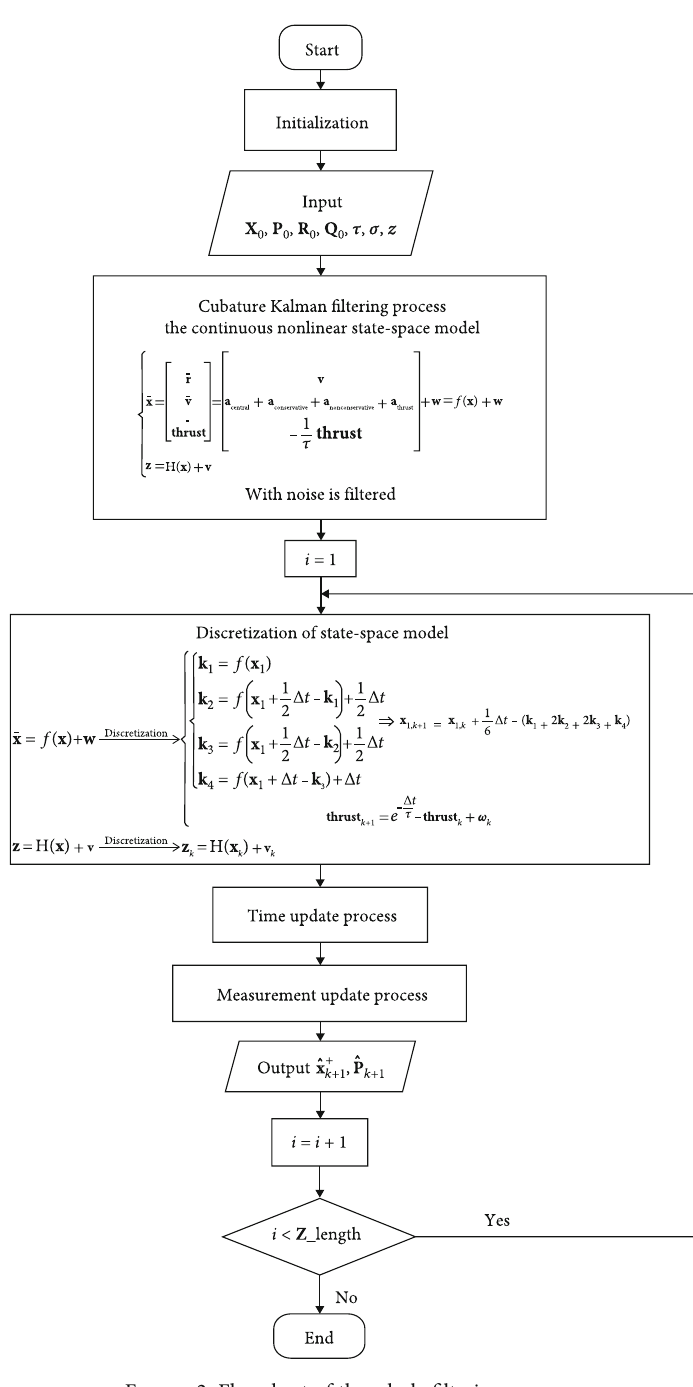
Figure 2: Flowchart of the whole fi ltering